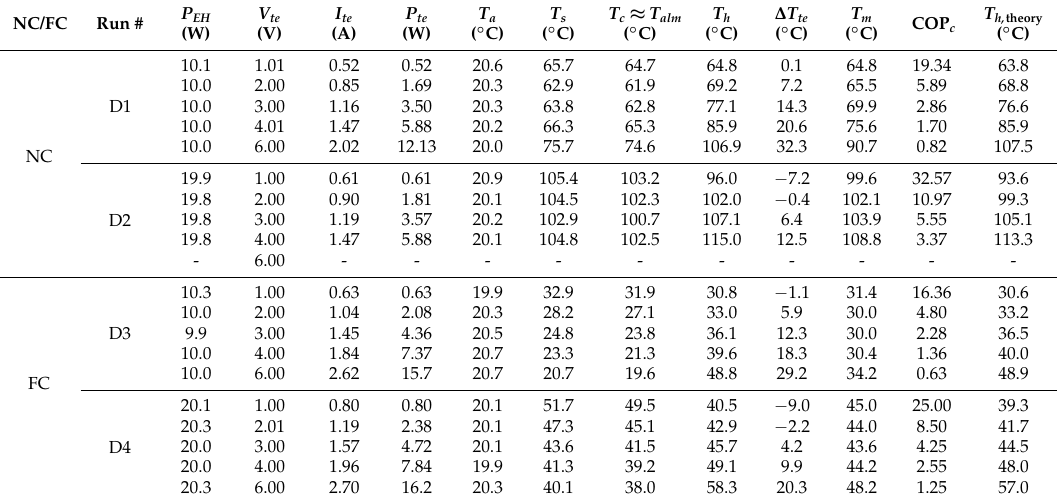
Figure 5. Experimental apparatus ( a ); and layout ( b ) to determine the thermal performance of the FHS-TE assembly. Table 1. Experimental results for FHS-TE (fin heat sinks-thermoelectric) assembly under natural (NC) and forced convection (FC).